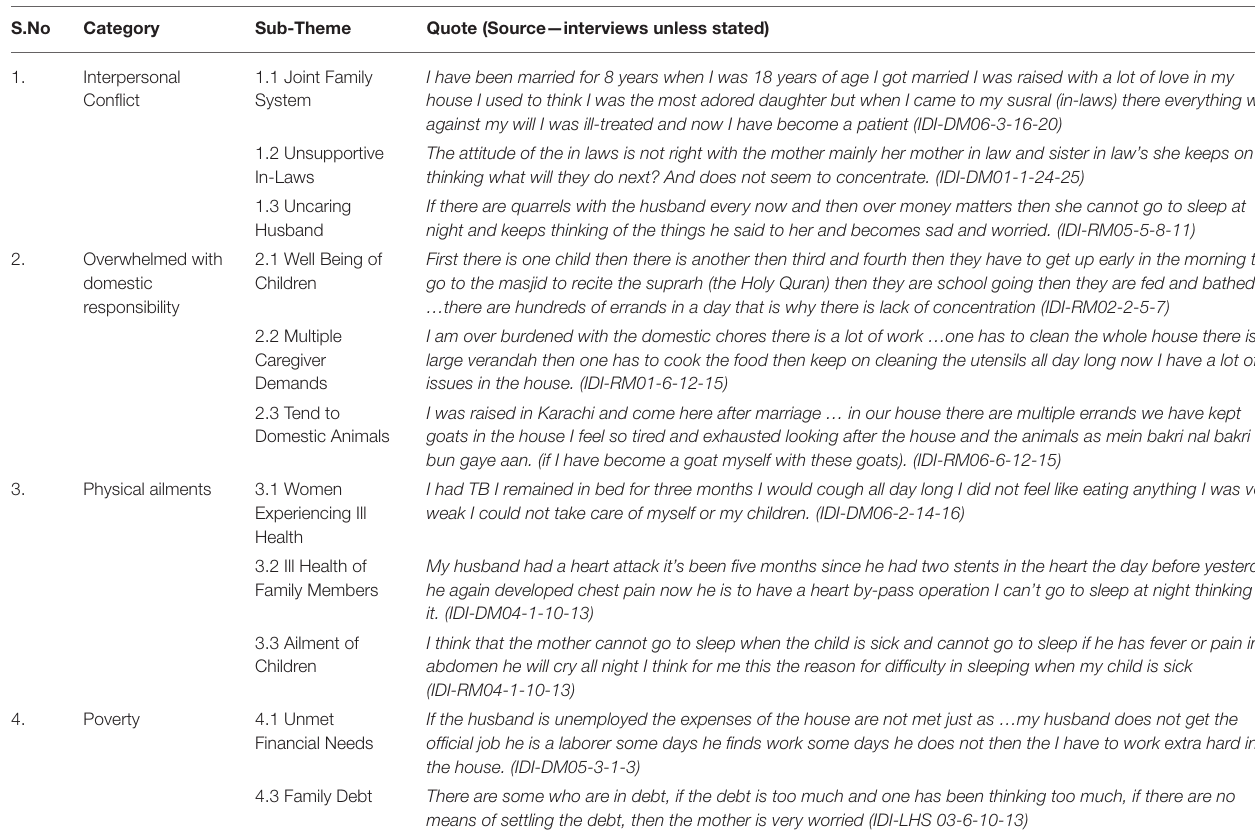
TABLE 2 | Cause of maternal